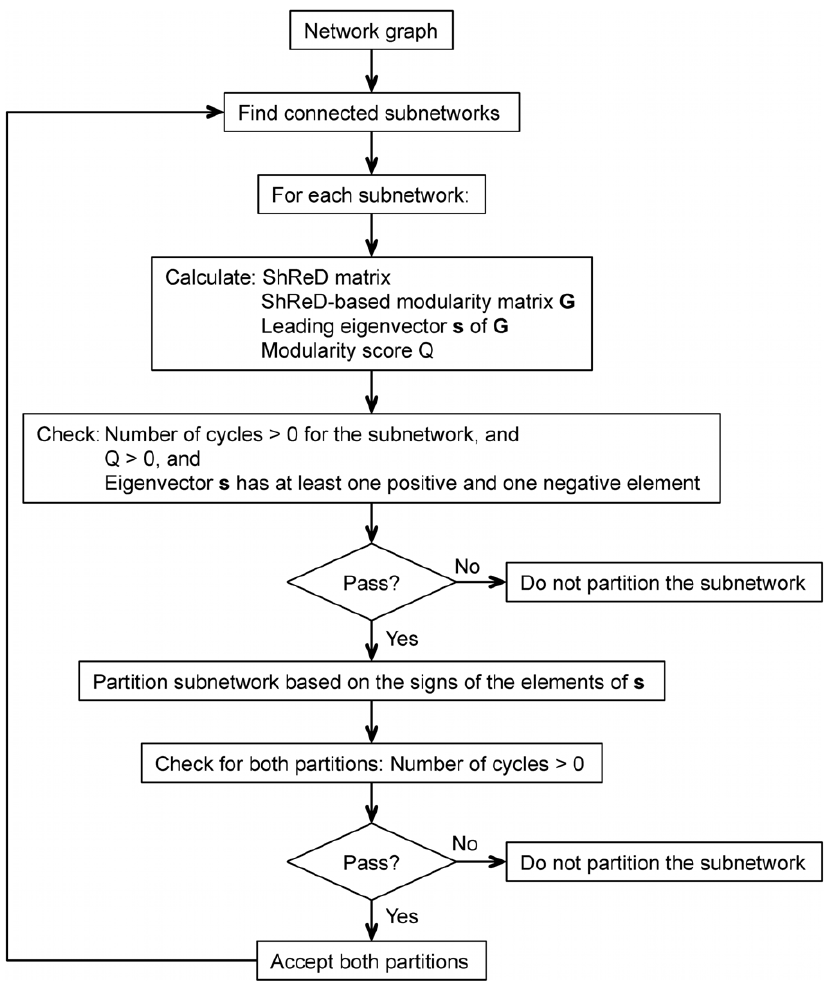
Figure 13. Schematic illustrating the flow of the partitioning algorithm.